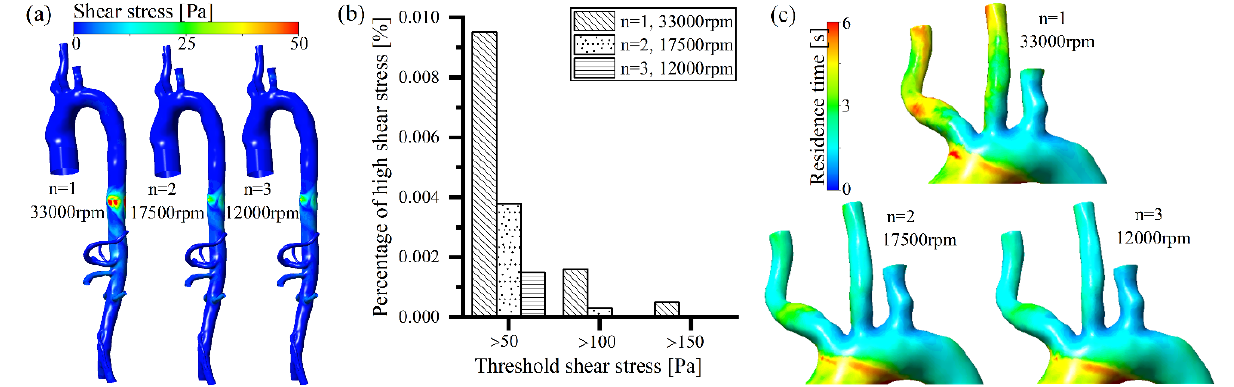
Figure 6. Effects of different pump positions on the blood damage-related parameters (shear stress and resident time): ( a ) effect on arterial shear stress distribution; ( b ) effect on high shear stress volume; ( c ) effect on residence time distribution.